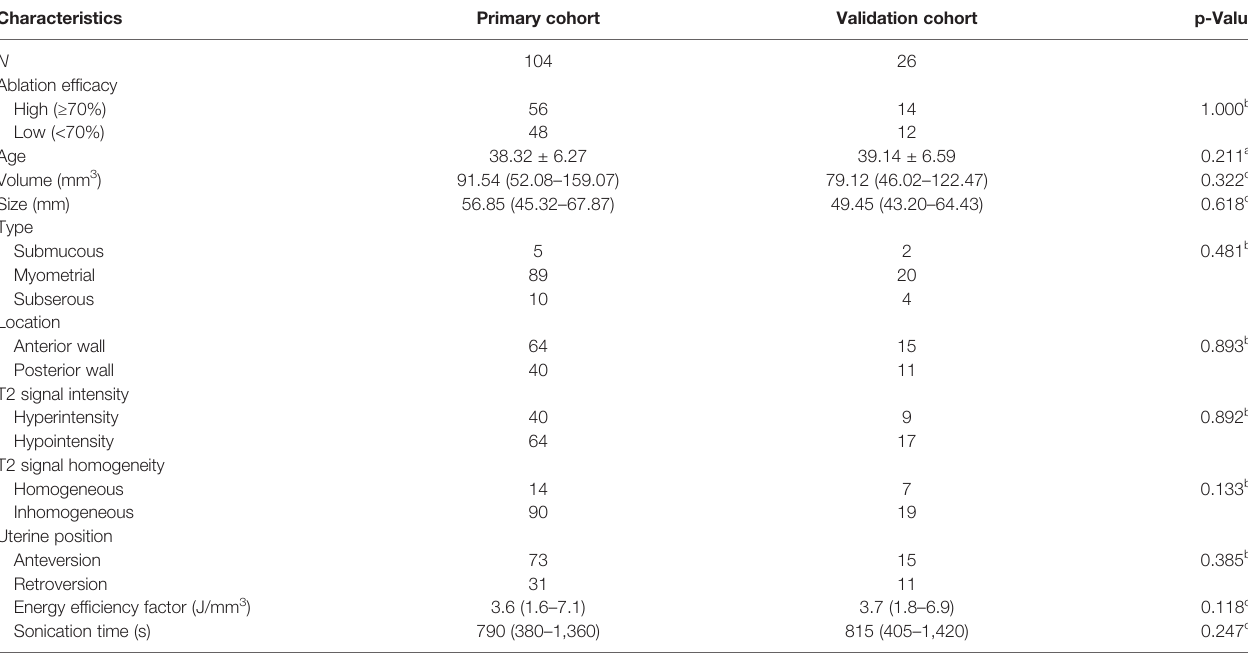
TABLE 2 | The comparison of demographic information and radiological image characteristics between primary and validation cohorts.